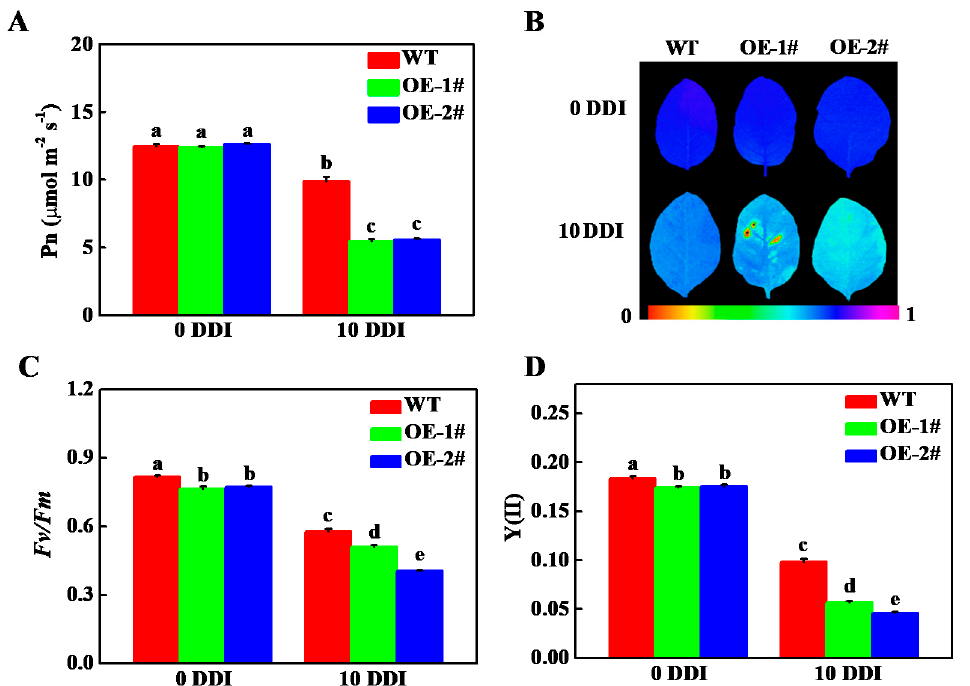
Figure 6. Effects of darkness on the photosynthesis and chlorophyll fluorescence of CsHCAR overexpression tobacco seedlings. ( A ) Net photosynthetic rate (Pn). ( B , C ) The maximum quantum yield of photosystem II ( Fv/Fm ). ( D ) The effective quantum yield of photosystem II [Y(II)]. The results represent the mean ± SE ( n = 3). Means with the same letter did not significantly differ at p < 0.05 according to Tukey’s test. WT, wild-type; OE-1# and OE-2#, 2 independent transgenic tobacco overexpression of CsHCAR ; DDI, day(s) of dark incubation.